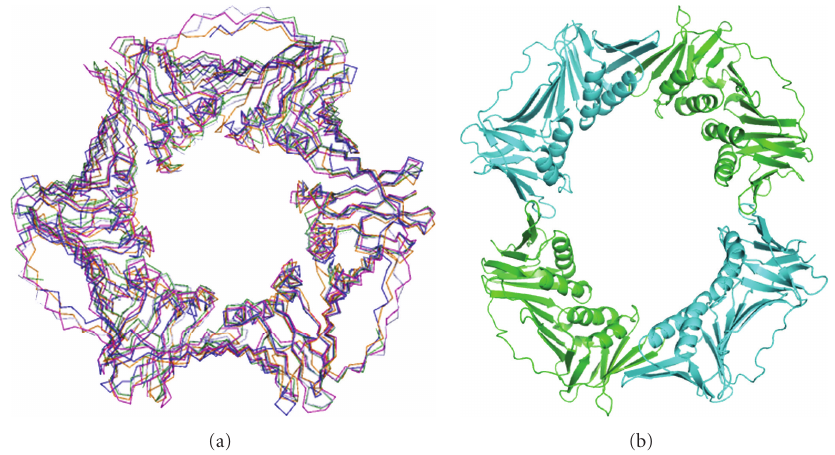
Figure 6: Global architecture of the archaeal PCNAs. (a) Superposition of the characterised homotrimeric PCNAs showing the high conservation of secondary and tertiary structure. HvoPCNA (blue-3IFV); PfuPCNA (green-1GE8); Tko PCNAs (light blue/magenta— 3LX1/3LX2); AfuPCNA (orange-1RWZ). (b) The heterotetrameric structure of Sulfolobus tokadii PCNA 2 and 3 (3AIZ) [6].